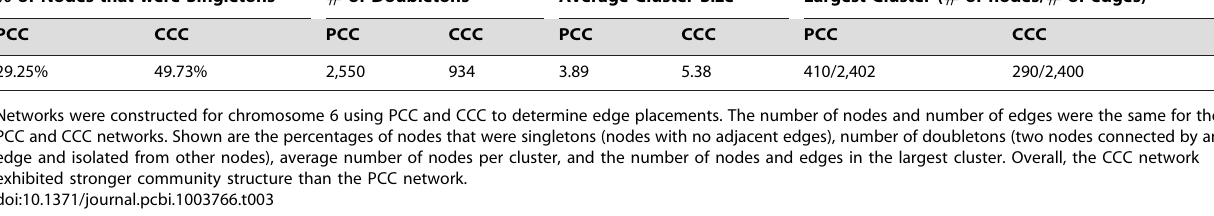
% of Nodes that were